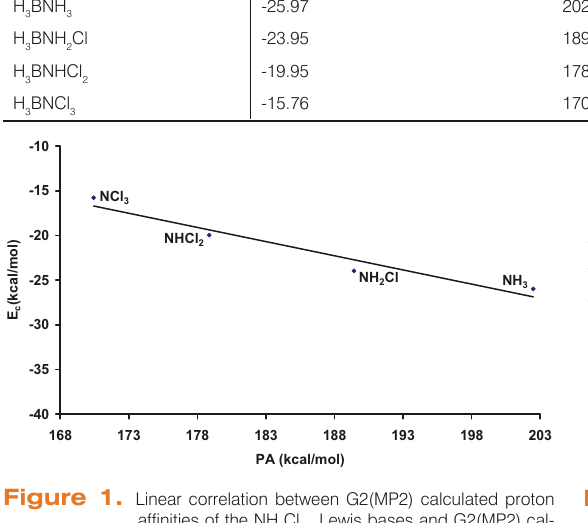
Cl bases to BH acid and n 3-n 3